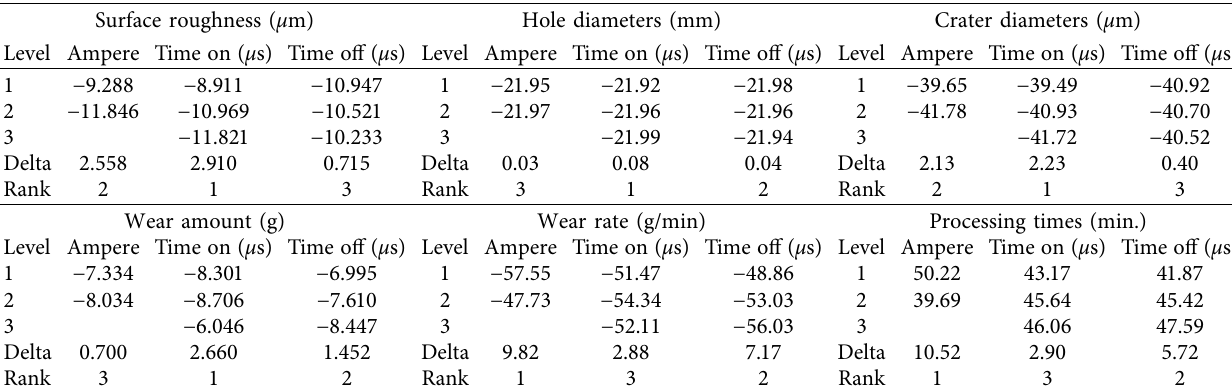
Figure 9: Effect of pulse time-on and time-off on hole diameter at 2 (a) and 4 (b) amperes. Table 4: Signal/noise values obtained from the experimental